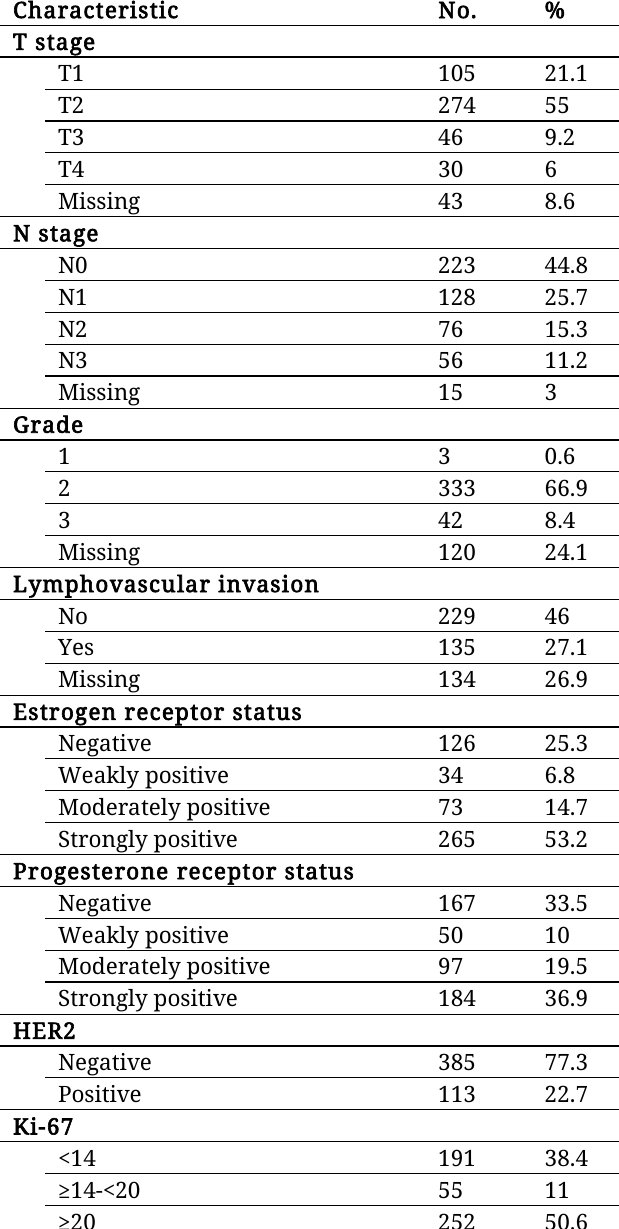
Table 1: Disease characteristics Characteristic